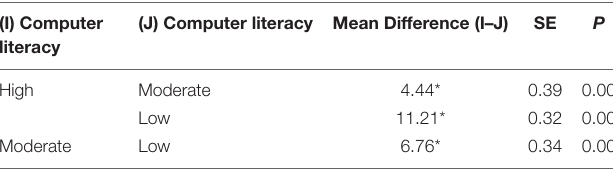
TABLE 6 | Fisher’s LSD test of multiple comparisons of ICT deployment based on the computer literacy levels of academic staff in public universities.